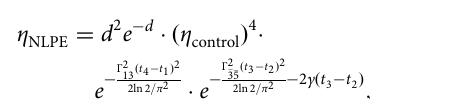
fi ts based on Eq.